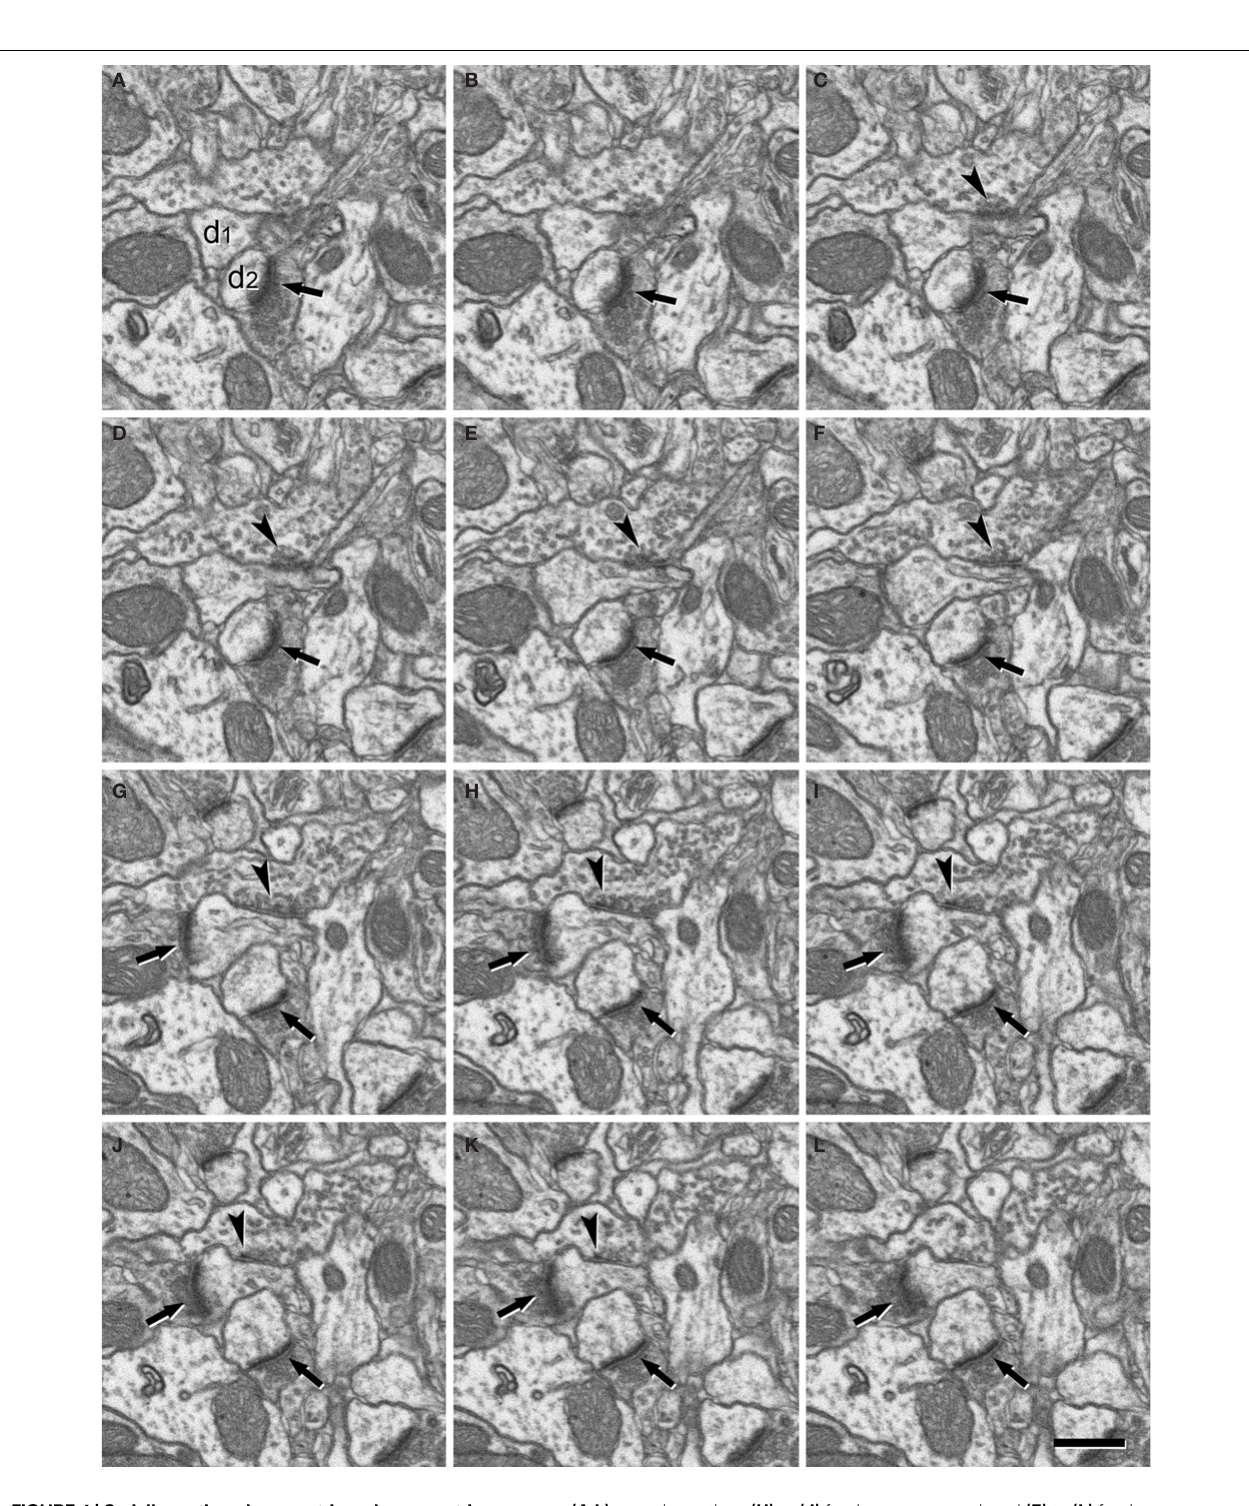
FIGURE 4 | Serially sectioned symmetric and asymmetric synapses. (A-L) Consecutive serial sections focused on two of the asymmetric synapses (arrows) and the symmetric synapse (arrowheads) shown in Figure 3 . These three synapses are established on two dendritic spines, labeled d section (A) . The different thickness between the pre- and post-synaptic densities is especially evident for the asymmetric synapses when they are sectioned perpendicular to the membranes and the synaptic cleft is visible,